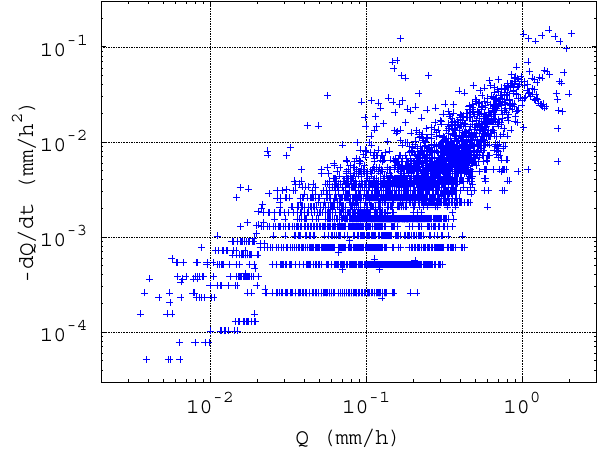
Fig. 2. Scatter of hourly ˙ Q vs. Q , excluding periods with precip- itation, high evaporation, or rising flow, at an example site (USGS gauge 01384500, Ringwood Creek, New Jersey; nonnegative ˙ Q val- ues not